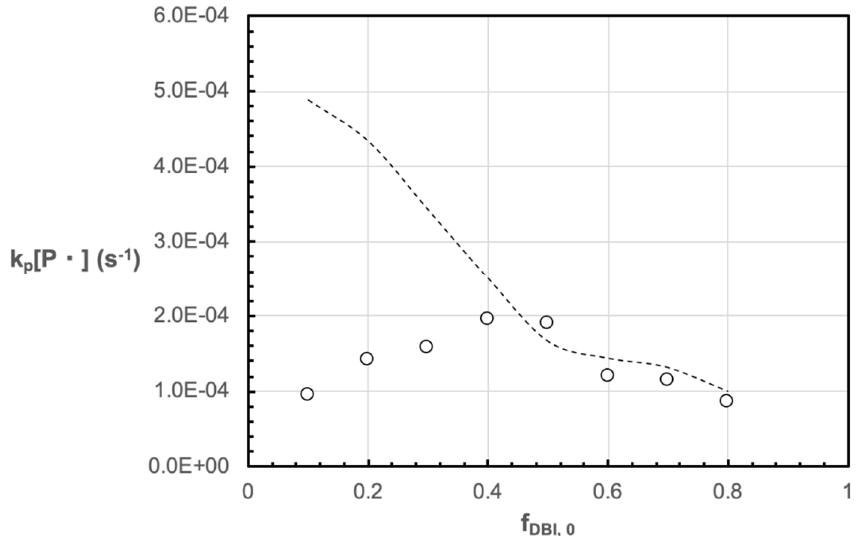
Figure 2. Apparent rate constant k p [P·] as a function of initial molar composition of dibutyl itaconate, f DBI, 0 , for DBI/S copolymerizations at 110 °C in 50 wt% dioxane solutions. The dashed lines indicate the prediction for k p [P·] based on the terminal model for the copolymerization.